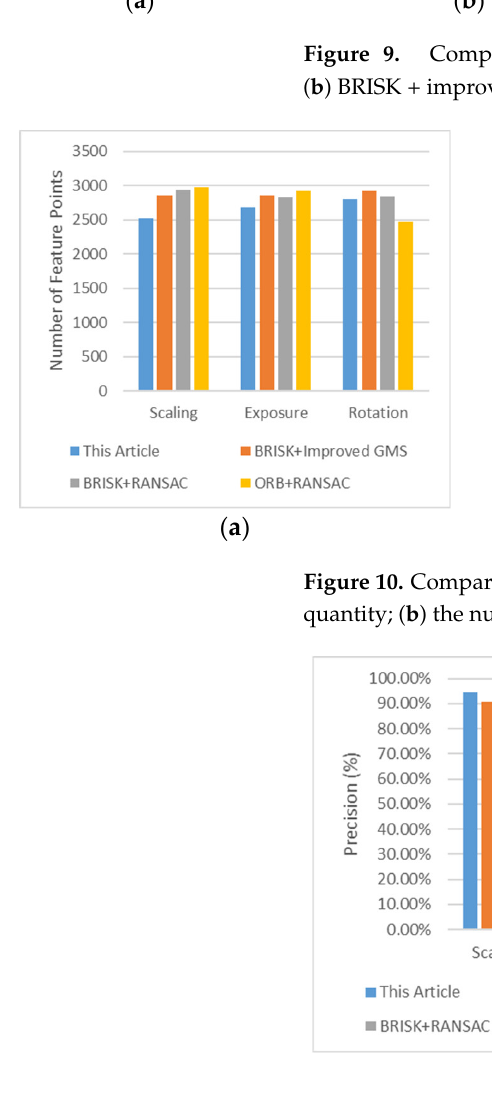
Figure 11. Comparison of image registration matching performance: ( a ) comparison of the matching accuracy of algorithms; ( b ) comparison of feature point extraction and matching time.